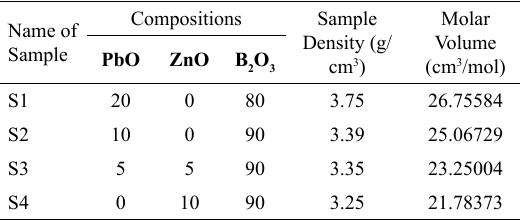
Table 1. Composites chemicals, density (ρ), molar volume (vm)